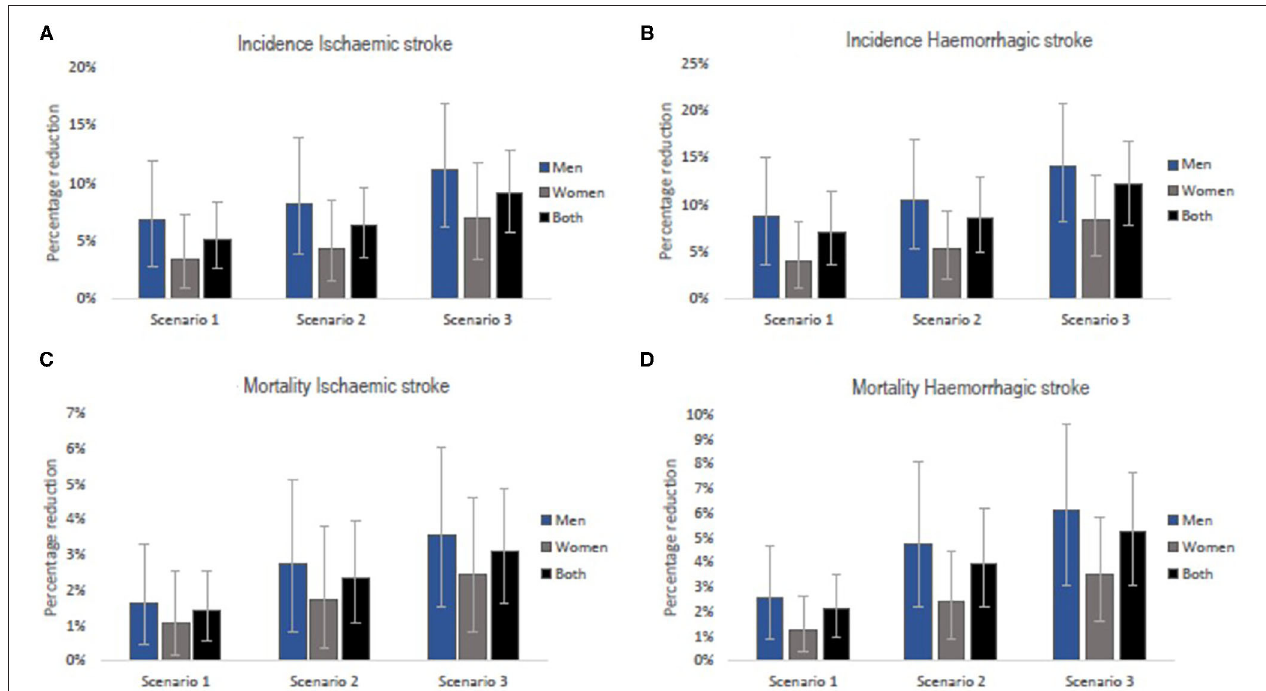
FIGURE 3 | Relative reductions in stroke incidence rates (A,B) and mortality rates (C,D) if the national (Scenarios 1 and 2) and WHO (Scenario 3) salt targets were achieved in Vietnam. The bars are the best estimates while the whiskers are the 95% uncertainty intervals, i.e., 2.5 and 97.5 percentiles.